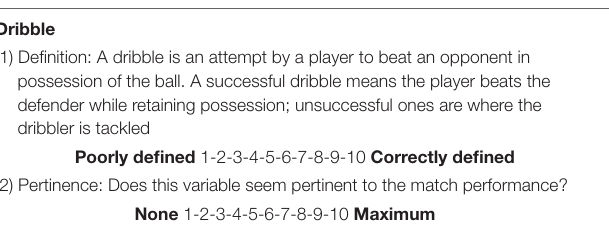
TABLE 1 | Illustration of questionnaire sent to experts.